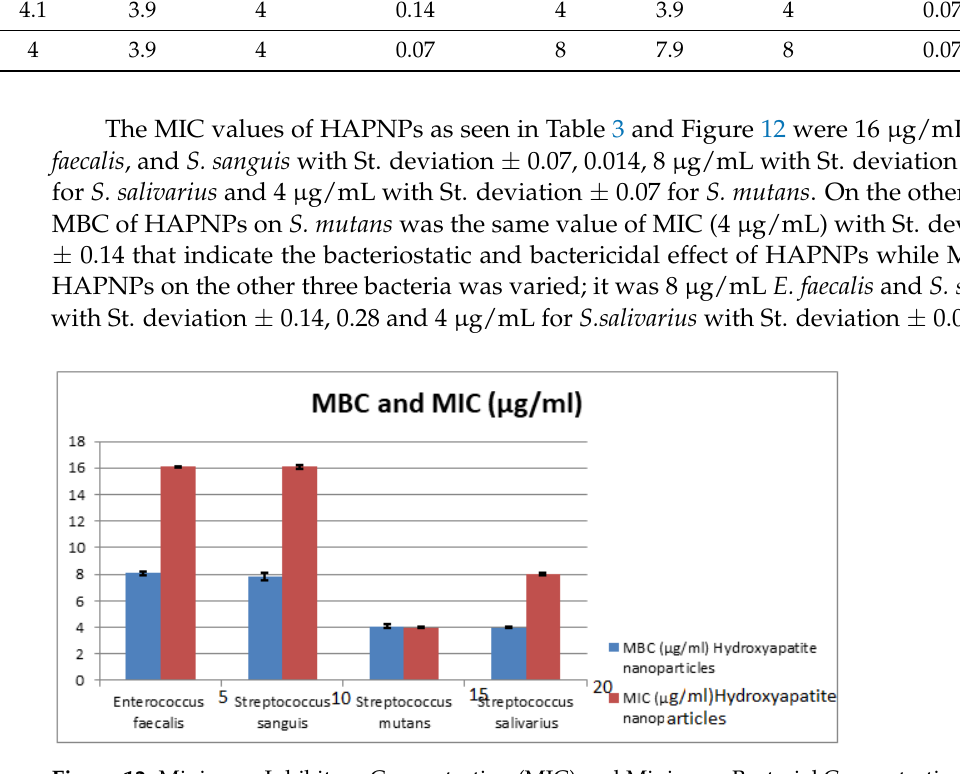
Figure 12. Minimum Inhibitory Concentration (MIC) and Minimum Bacterial Concentration (MBC) of CSNPs. HAPNPs against Streptococcus sanguis, Enterococcus faecalis, Streptococcus mutans, and Streptococcus salivarius.